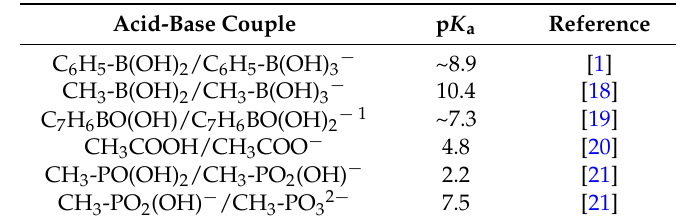
Table 1. p K a values (in water, at 25 ˝ C) of simple boronic acids/benzoxaboroles, in comparison to other organic